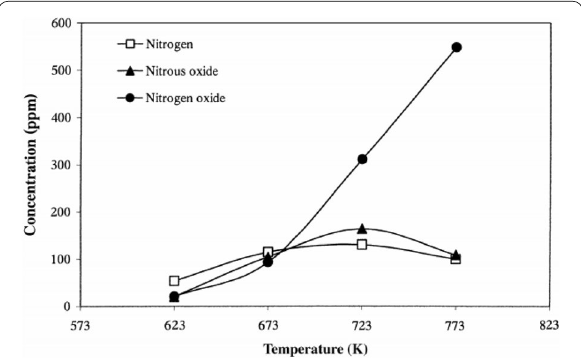
Fig. 17 NH 3 oxidation on vanadium catalyst